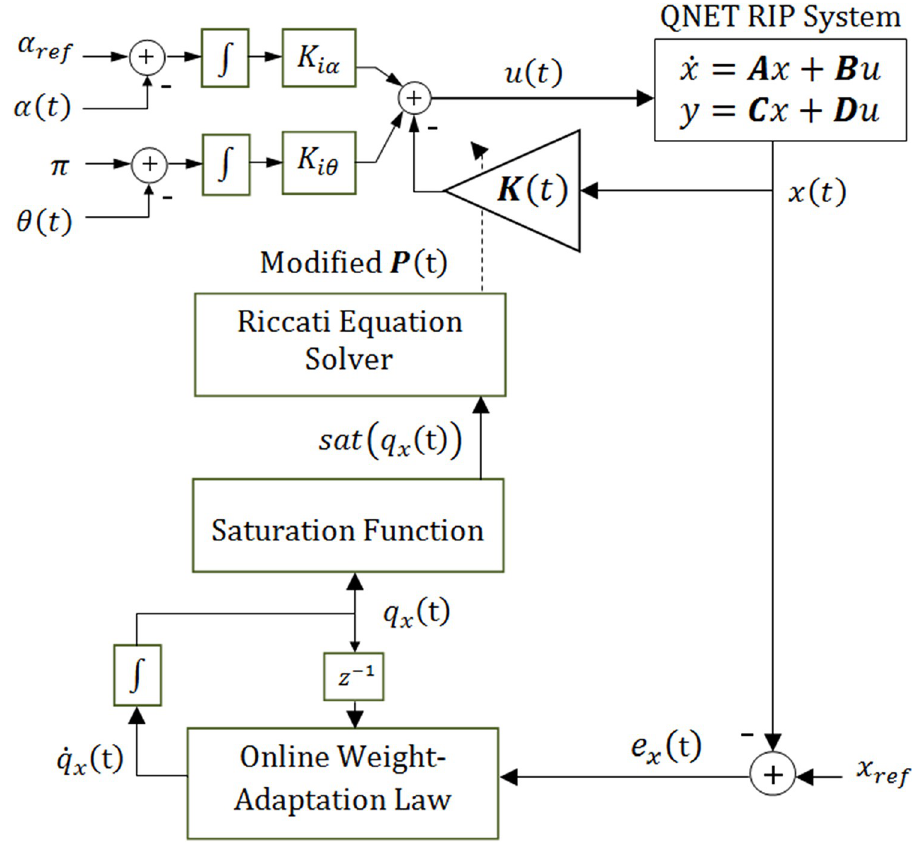
Fig 2. Baseline variable–structure LQIC